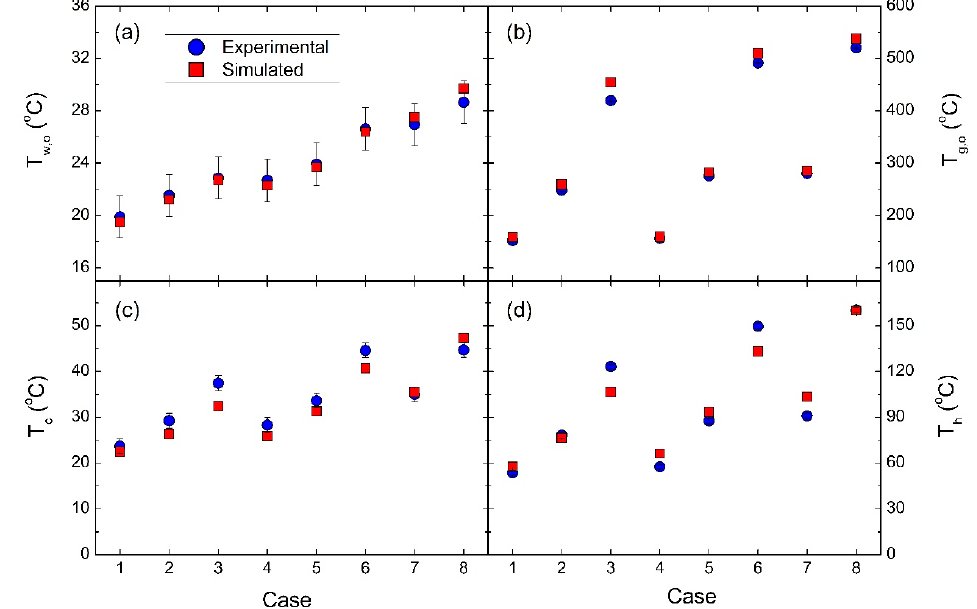
Figure 6 . Experimental and simulated temperatures of ( a ) water at the ATEG outlet; ( b ) exhaust